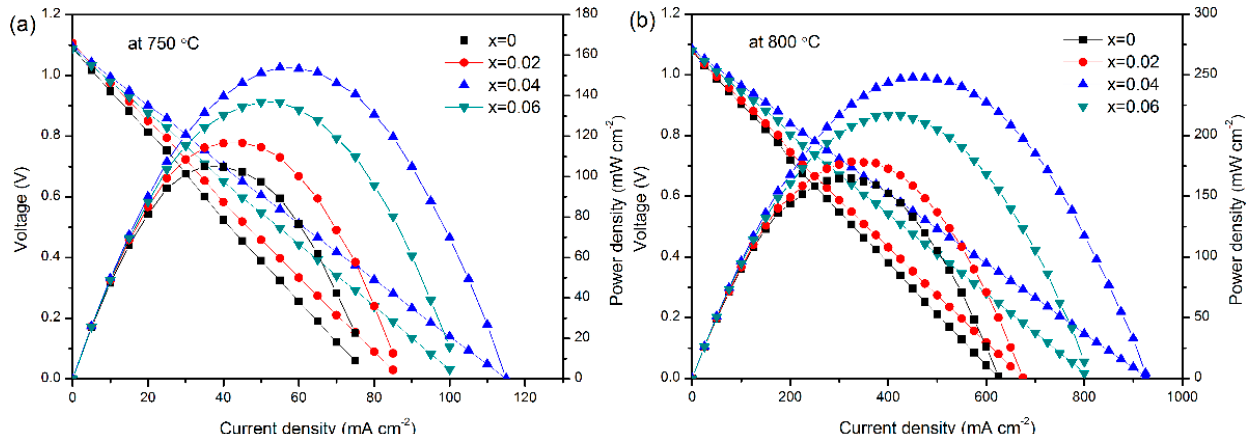
Figure 7. Output performance of the single cells with LBCM x ( x = 0–0.06) cathodes at ( a ) 750 ◦ C and ( b ) 800 ◦